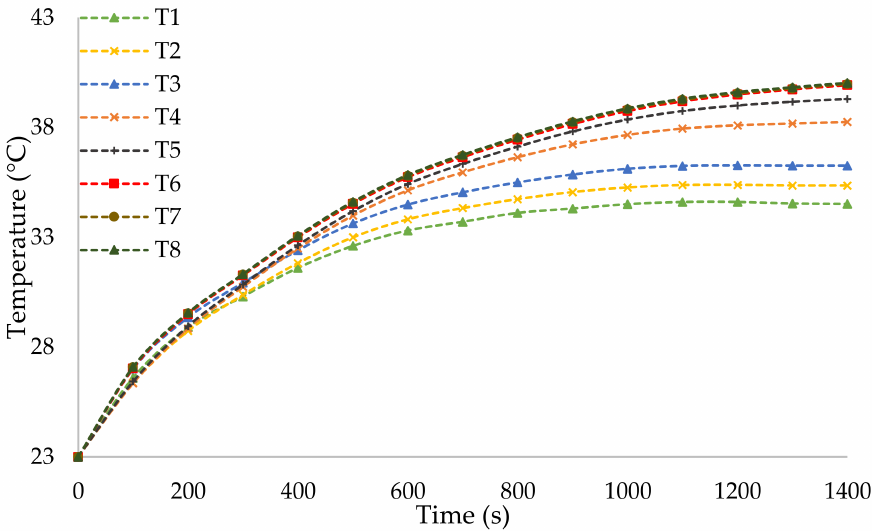
Figure 12. The simulation results: the temperature evolution of the module regarding the eight thermocouples embedded on top surfaces of the cells.